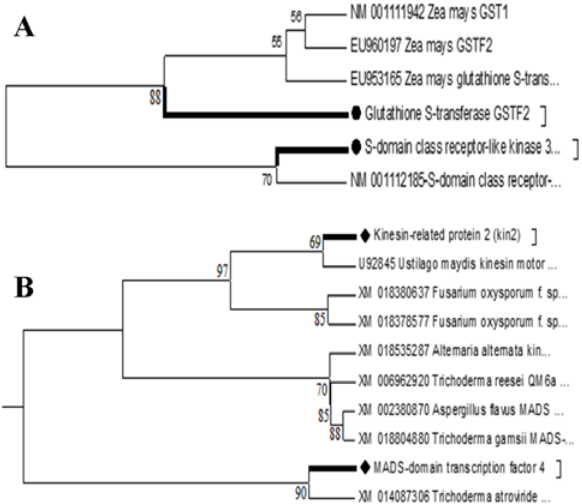
Figure 4. Dendrograms illustrating the phylogenetic rela- tionships of the selected up- (A) and down-regulated (B) genes in comparison with the DNA nucleotide sequences of other genes listed in the GenBank database .